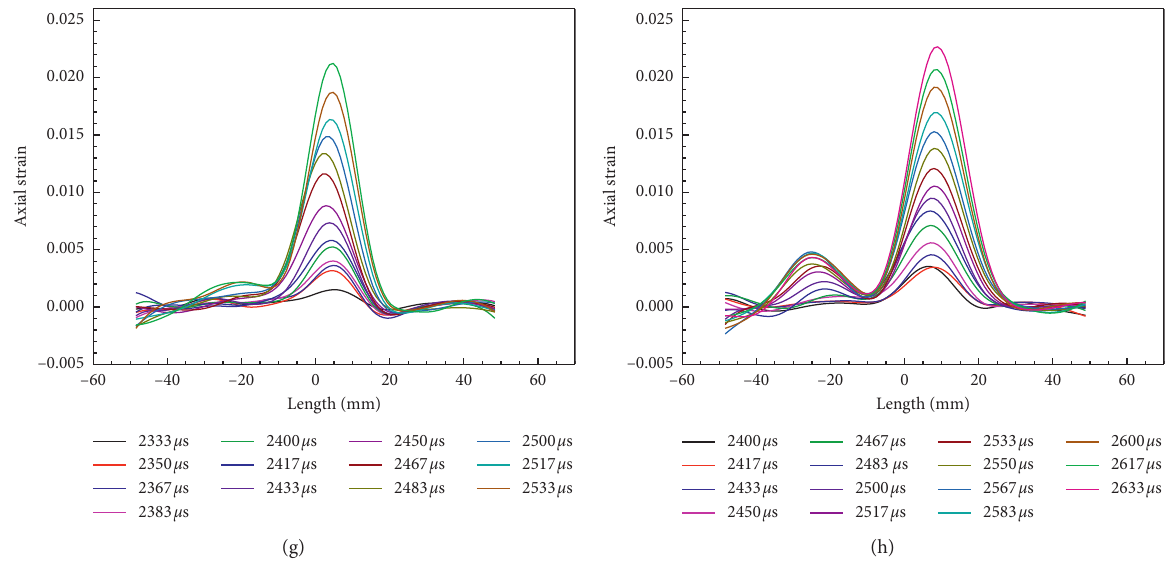
Figure 9: Axial strain on the line of interest at a different time for test 1. (a) LOI 1, (b) LOI 2, (c) LOI 3, (d) LOI 4, (e) LOI 5, (f) LOI 6, (g) LOI 7, and (h) LOI 8.